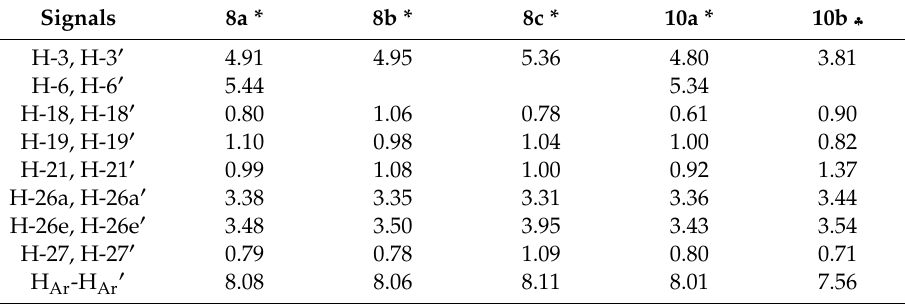
Table 3. Selected 1 H-NMR signals of the 8a–c and 10a–b in ppm.